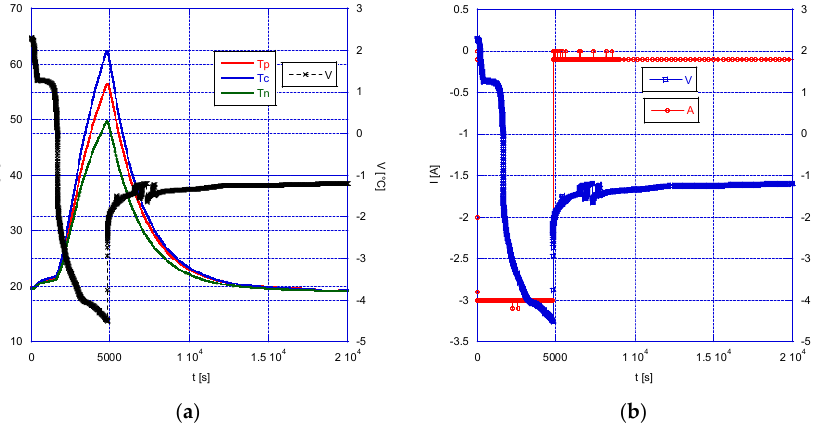
Figure 13. LTO cell. Overdischarge test, DOD% = 140%: ( a ) temperature and voltage trend of the abused cell, ( b ) current and voltage trend of the abused cell.